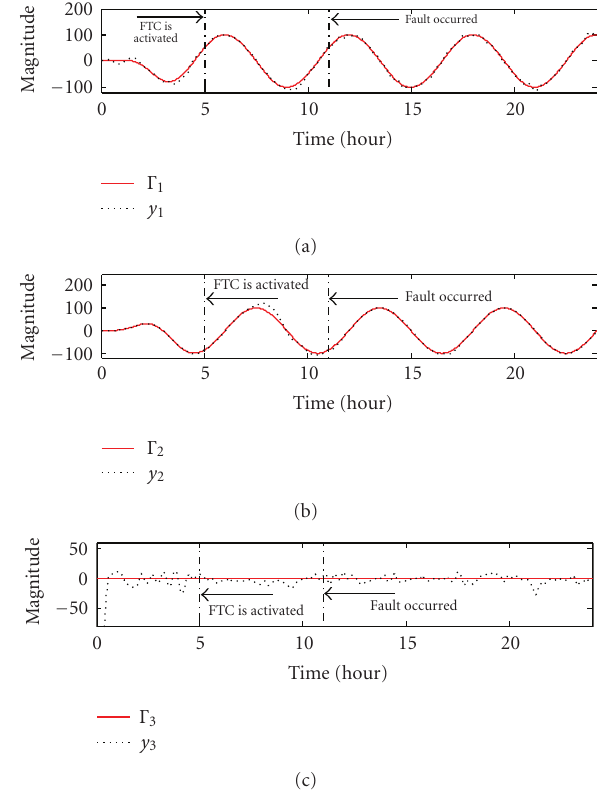
Figure 17: Output responses of Scenario 2 with fault-tolerant control.